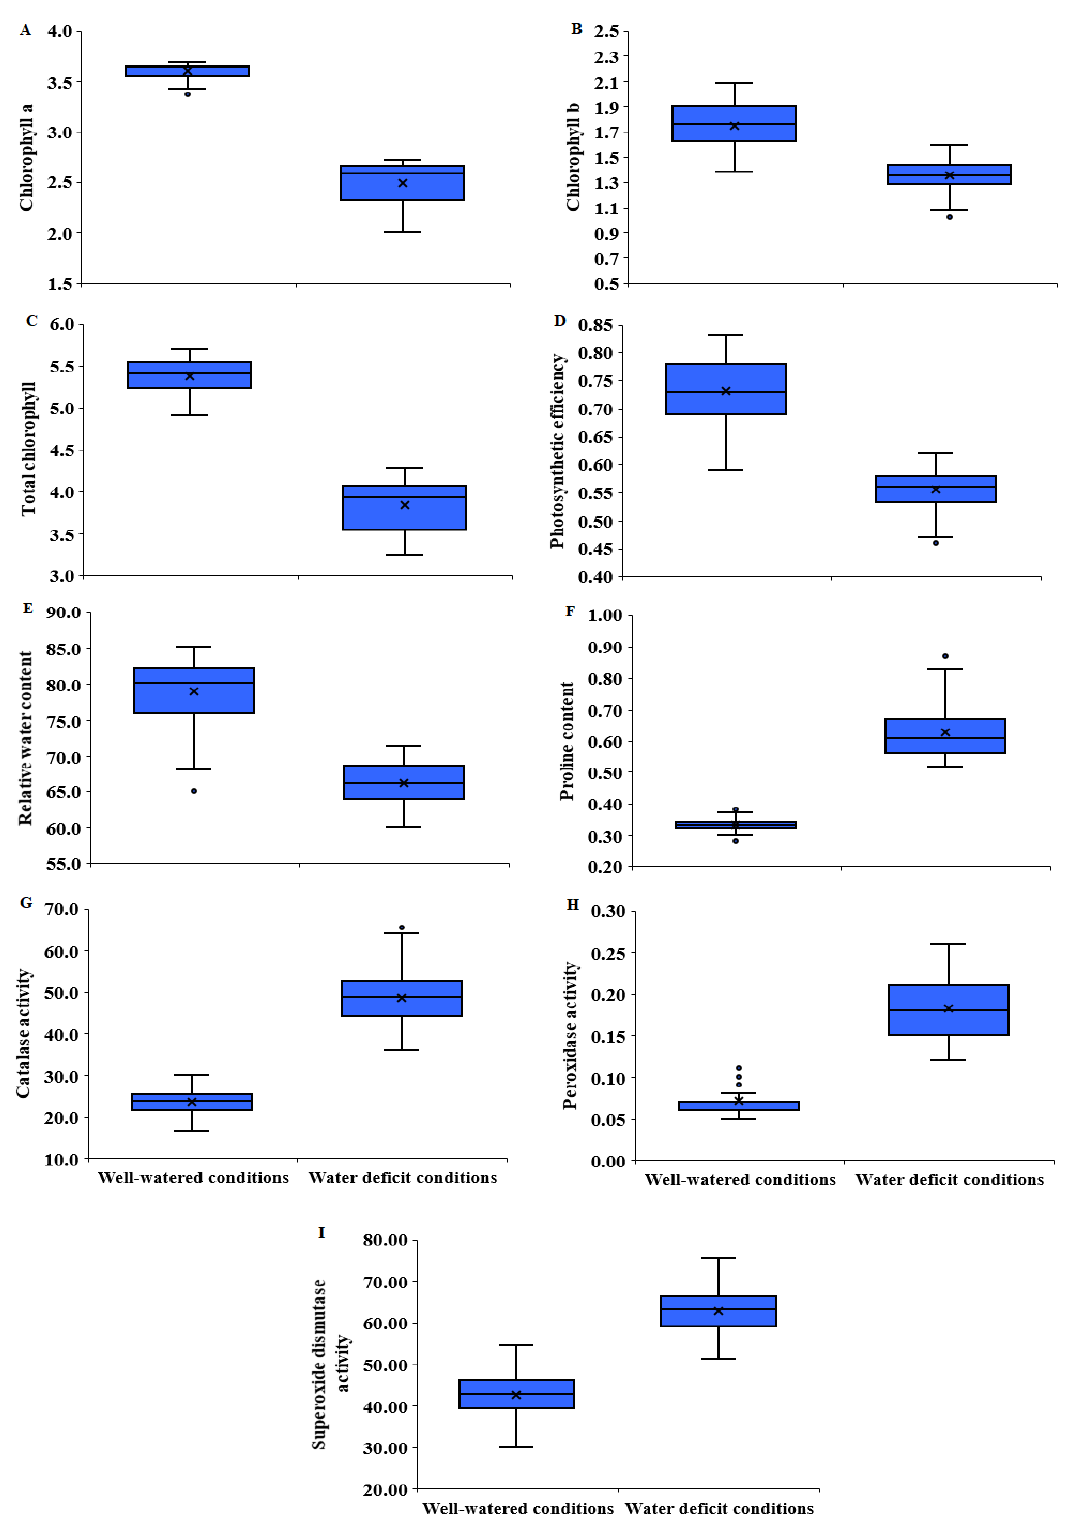
Figure 2. Boxplots with minimum, median, mean, and maximum values for chlorophyll a ( A ), chlorophyll b ( B ), total chlorophyll content ( C ), photosynthetic efficiency ( D ), relative water content ( E ), proline content ( F ), catalase activity ( G ), peroxidase activity ( H ), and superoxide dismutase activity ( I ).